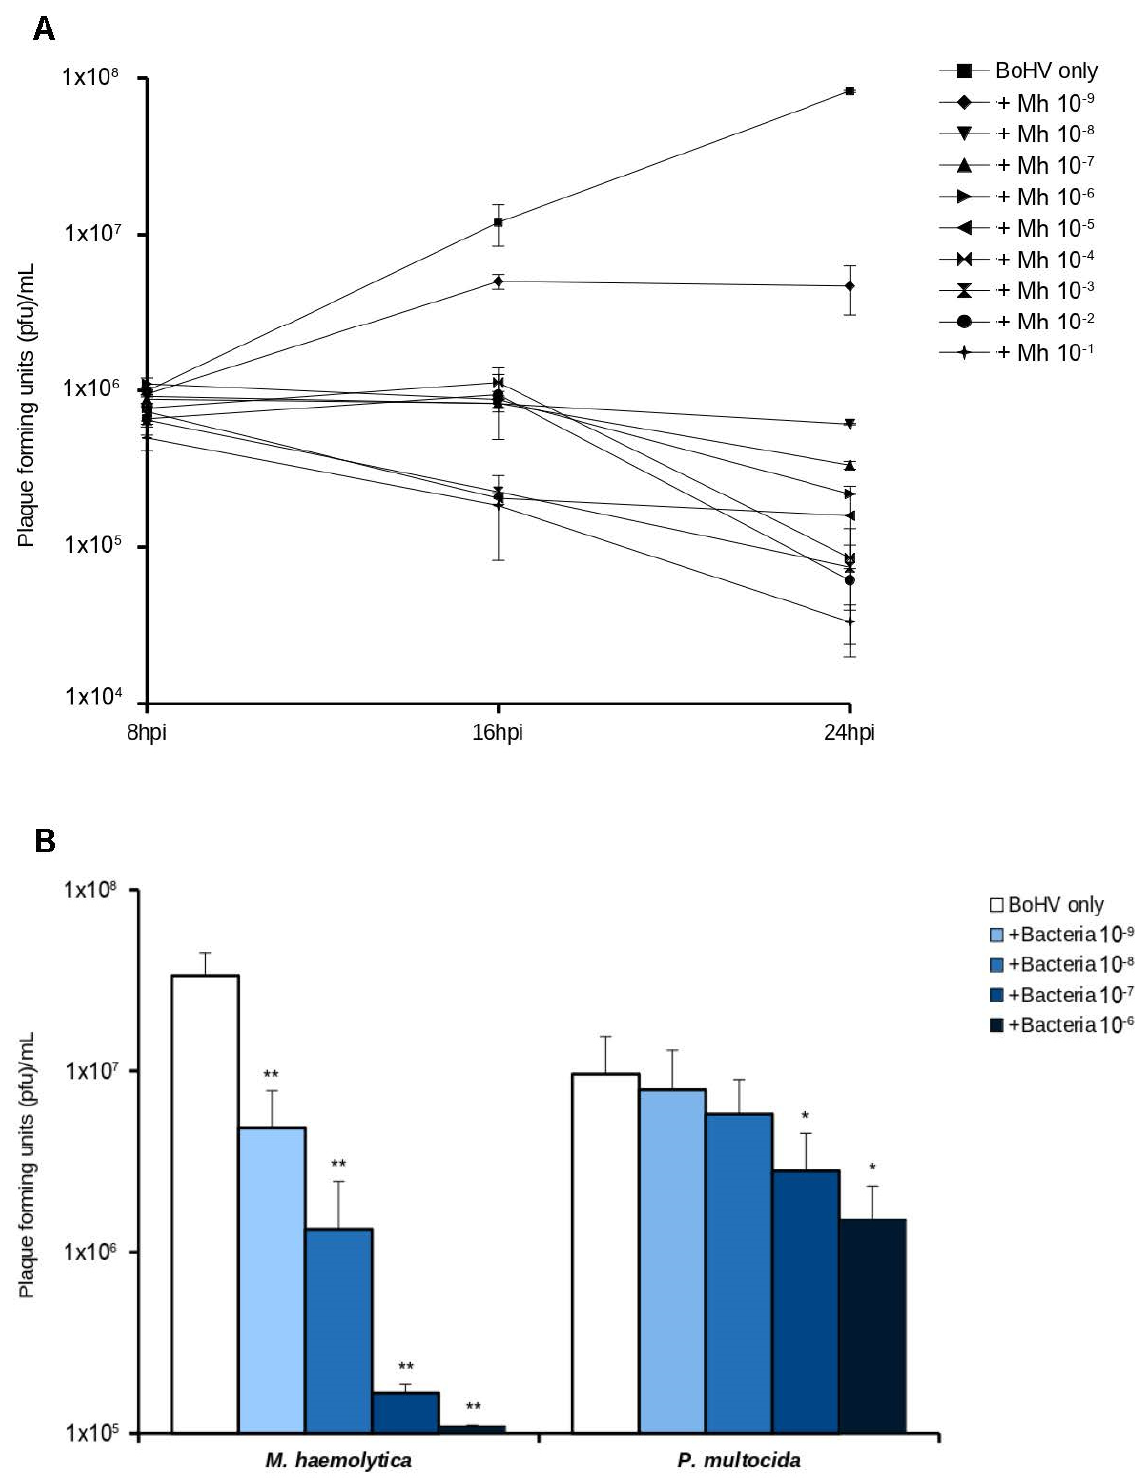
Figure 1. ( A ) Simultaneous co-infection of MDBK cells with BoHV-1 and M. haemolytica . MDBK cells were infected simultaneously with increasing doses of bacteria (dilutions 10 − 6 –10 − 9 ) and BoHV-1 (MOI 1) for 24 h. Culture supernatants were collected at 8, 16, and 24 hpi and pfu/mL were quantified. ( B ) Viral quantification resulting from simultaneous co-infection with BoHV-1 (MOI 1) and M. haemolytica or P. multocida (dilution range 10 − 6 to 10 − 9 ). Significance levels between the means were tested by comparing against the “BoHV only” infection in each group (*, p < 0.05; **, p < 0.01).